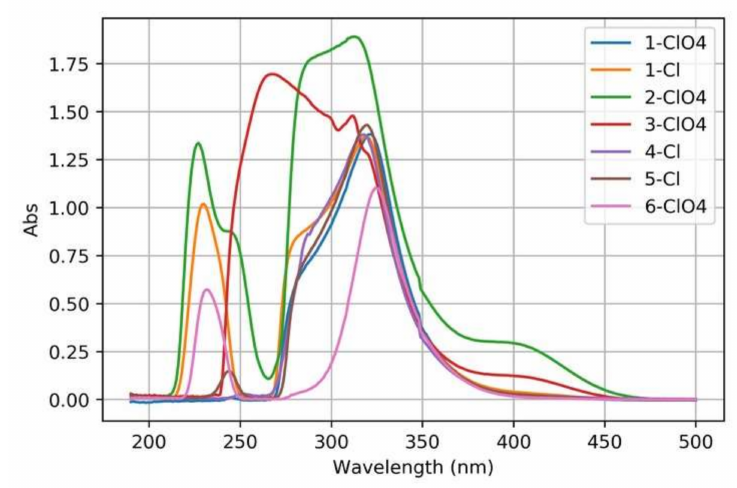
Figure 6. UV-VIS spectra of bis( p -nitrophenyl)phosphate (BNPP) (270 µ M) in MOPS buffer (10 mM, pH 7.4) in the presence of Cu(II) complexes (540 µ M) after 48 h incubation at 37 ◦